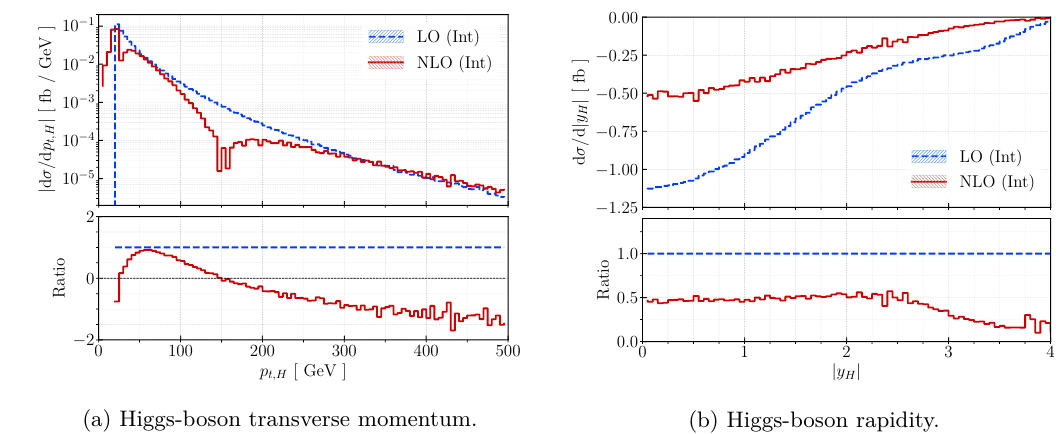
Figure 3 . The transverse momentum and rapidity distributions of the Higgs boson calculated at LO (blue) and NLO (red) for central scale choice. We only consider the interference contribution. We note that the absolute value of d σ Int / d p t,H is displayed in the left panel. This implies that this distribution actually changes sign at around p t,H ∼ 150 GeV . The lower panels show ratios to the LO interference